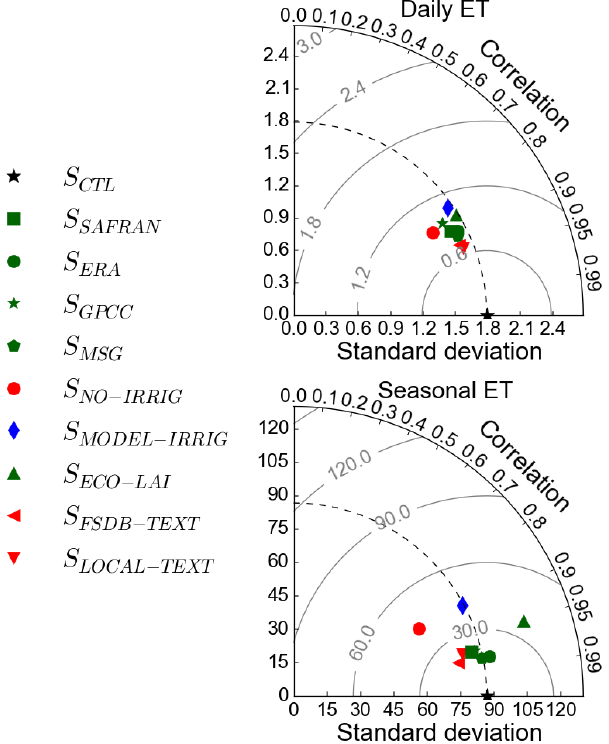
Figure 12. Deviations in daily and seasonal cumulative ET between each experiment and the control run (S CTL ) summarized by a Tay- lor diagram (Taylor, 2001). The contour lines indicate the RMSD between each simulation and S CTL . The y axis indicates the stan- dard deviation of each tested simulation while the x axis indicates the standard deviation of S CTL . The colours indicate the magnitude of the MD between each simulation and S CTL . Blue indicates very low MD close to zero. Green indicates intermediate MD and red represents the largest MD. Numerical values are reported in Table